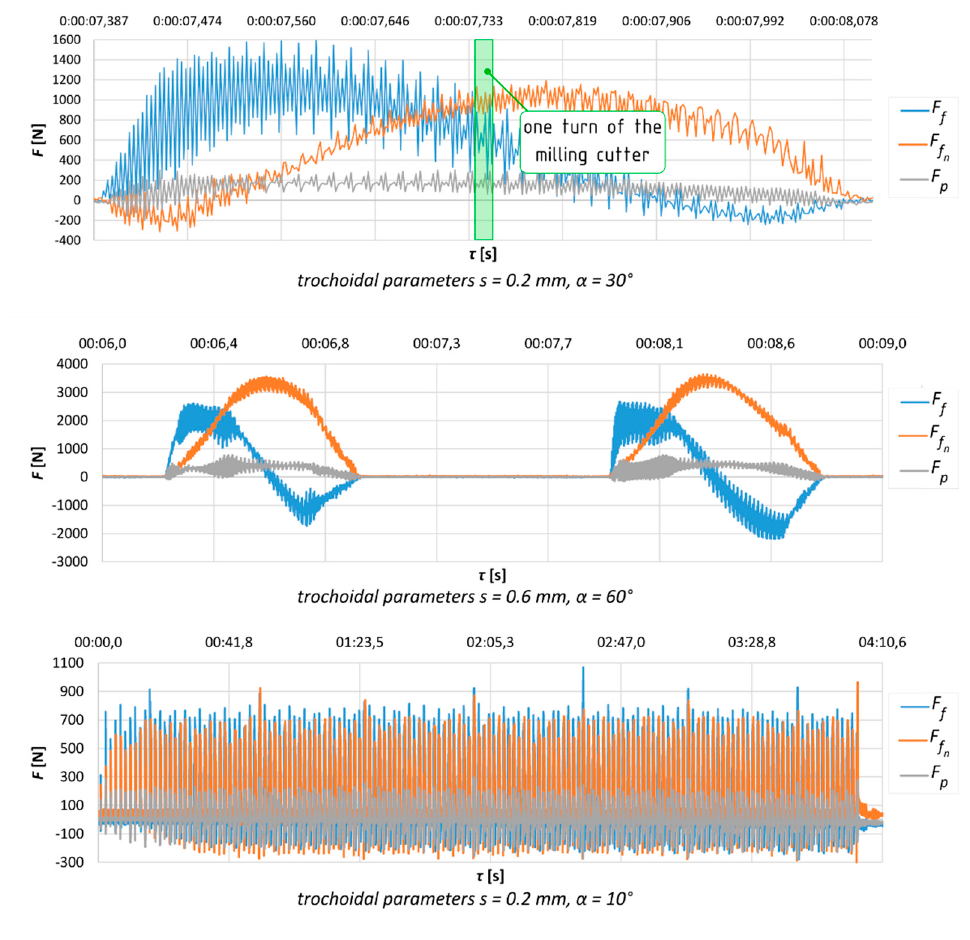
Figure 9. Time recording of the evolution of the cutting force components for selected cases ( top —detail of one pass; bottom —the progress as a whole).